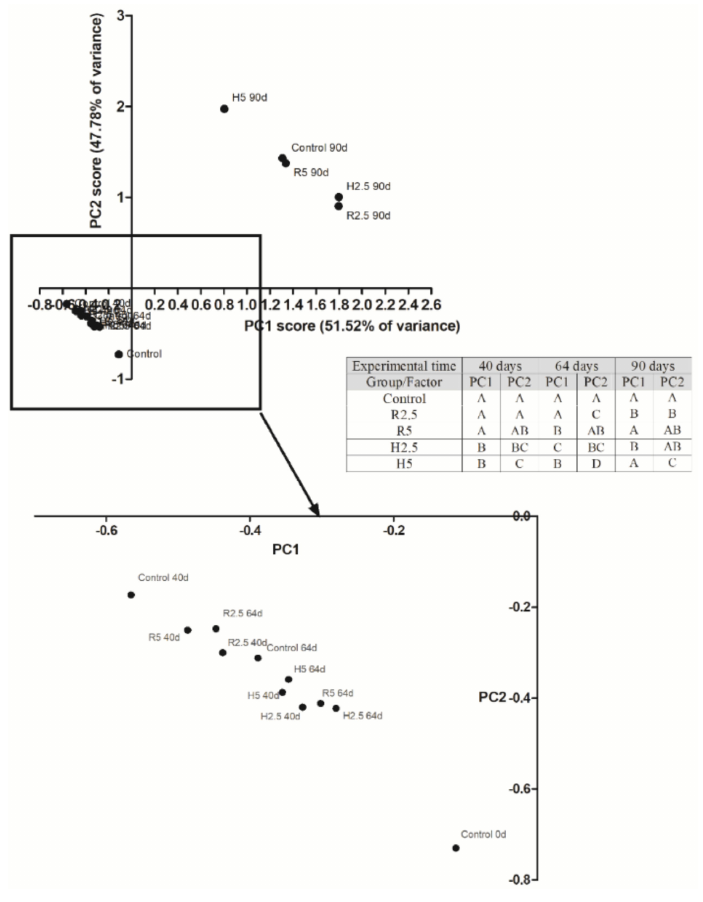
Figure 2. Scatter plot of the mean values of PC1 (isometric size) and PC2 (allometric shape) accordingly with the PCA analysis for the di ff erent experimental groups after 0, 40, 64 and 90 days of treatment with a diet containing 2.5 or 5% of raw (R2.5 and R5, respectively) or hydrolyzed (H2.5 or H5, respectively) microalgae biomass or a diet without microalgae biomass (Control). Statistical analysis was performed by two-way ANOVA followed by Duncan’s post-hoc analysis. Inset: Di ff erent letters indicate significant di ff erences ( p < 0.05) among groups.